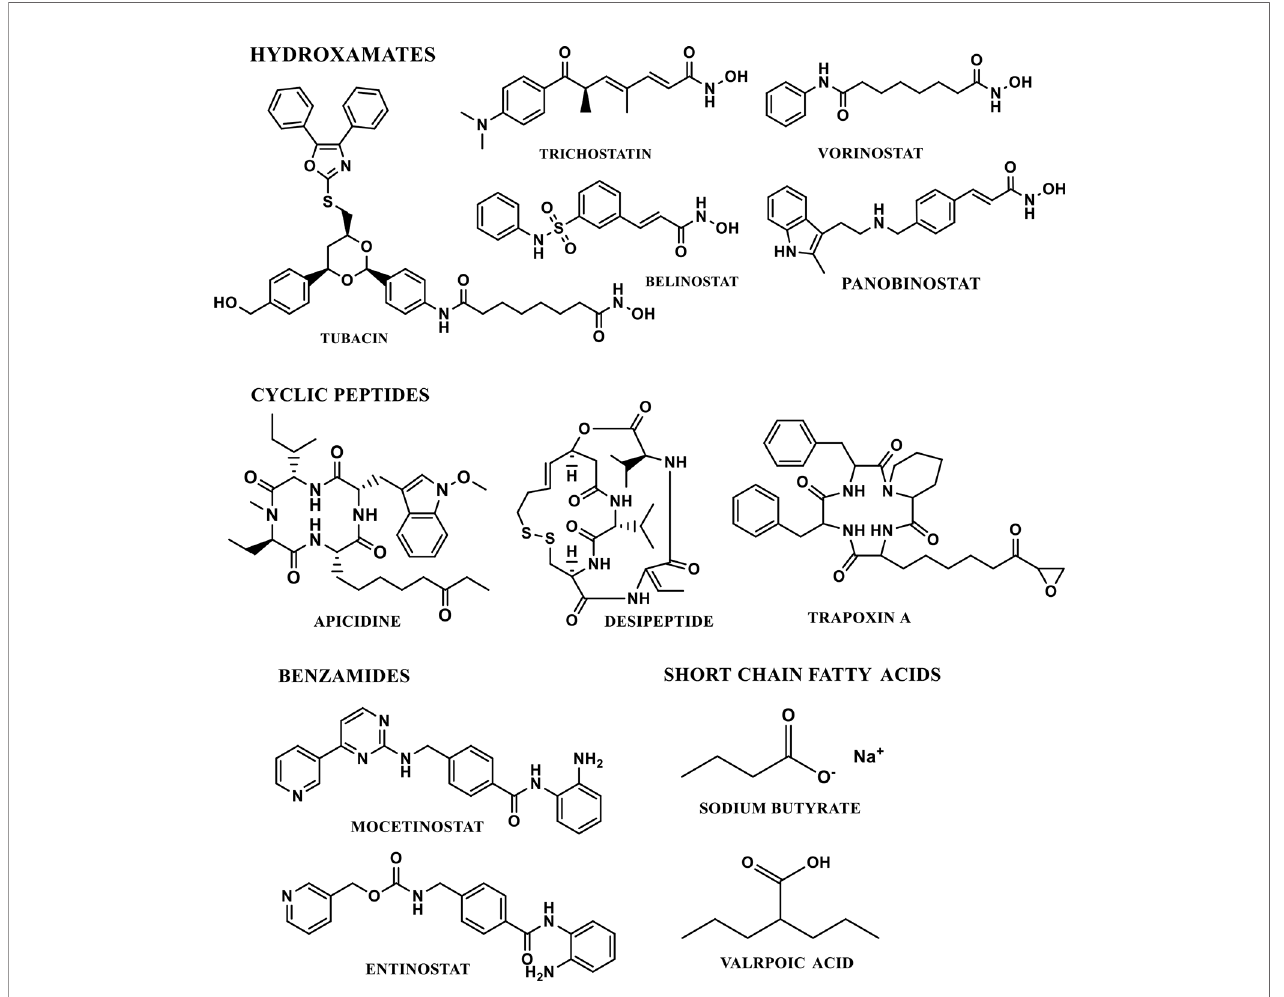
FIGURE 5 | Chemical classes and structures of selected HDAC